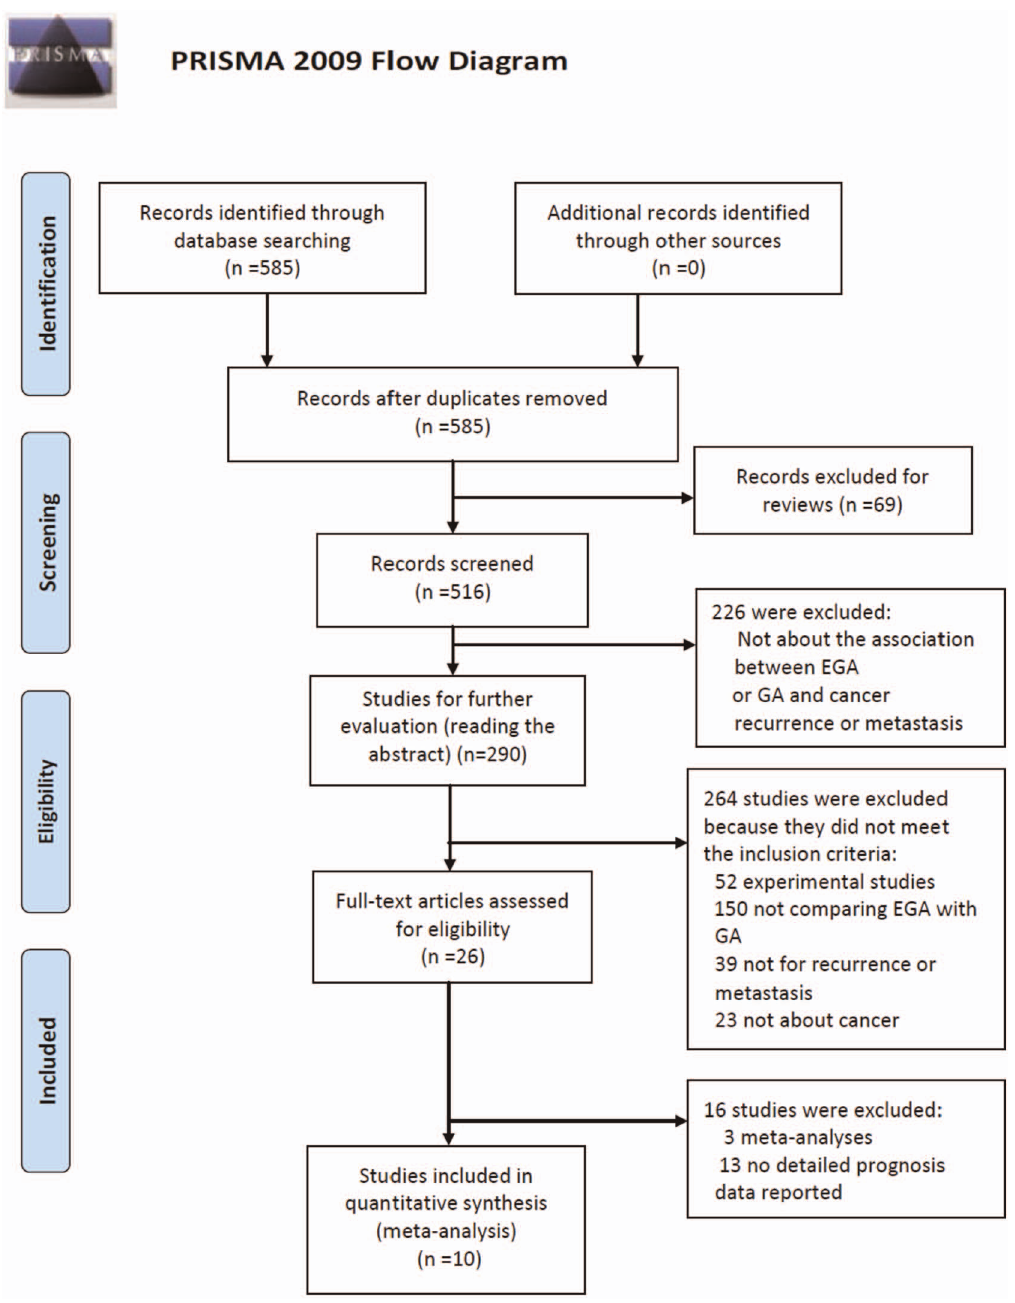
Fig. 1. Flowchart of included and excluded